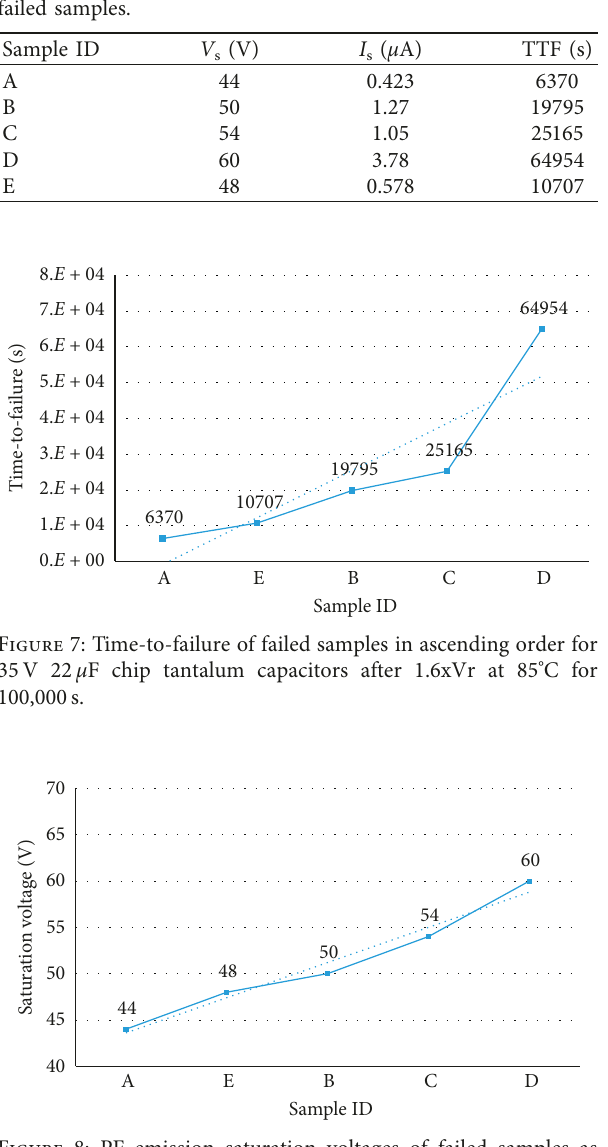
s ), leakage currents ( I s ), and TTF of